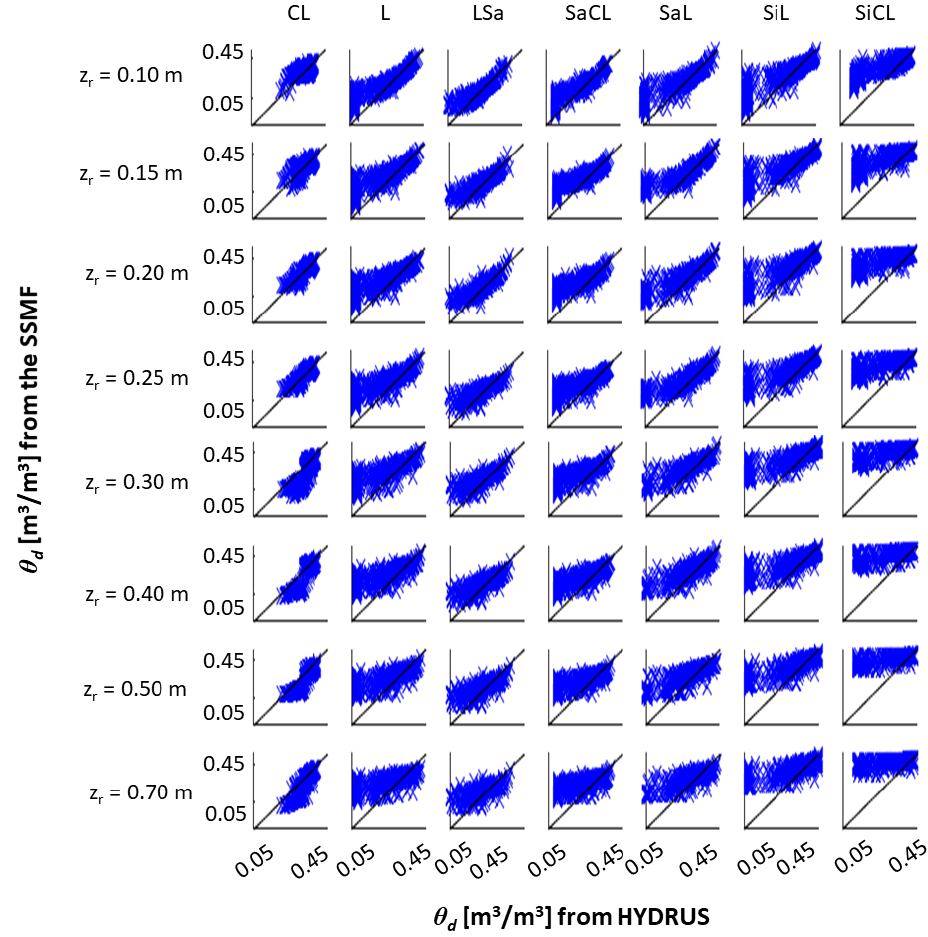
Figure 5. Scatter plots of the soil water content θ d values [m 3 / m 3 ] from the Shallow Subsurface Modelling Framework (SSMF) (y-axis) and from HYDRUS (x-axis), across the eight studied depths z r (rows), and for the seven soil profiles (columns): CZO clay loam (CL), loam (L), loamy sand (LSa), sandy clay loam (SaCL), sandy loam (SaL), silt loam (SiL) and silty clay loam (SiCL). The black line represents the 1:1 line.